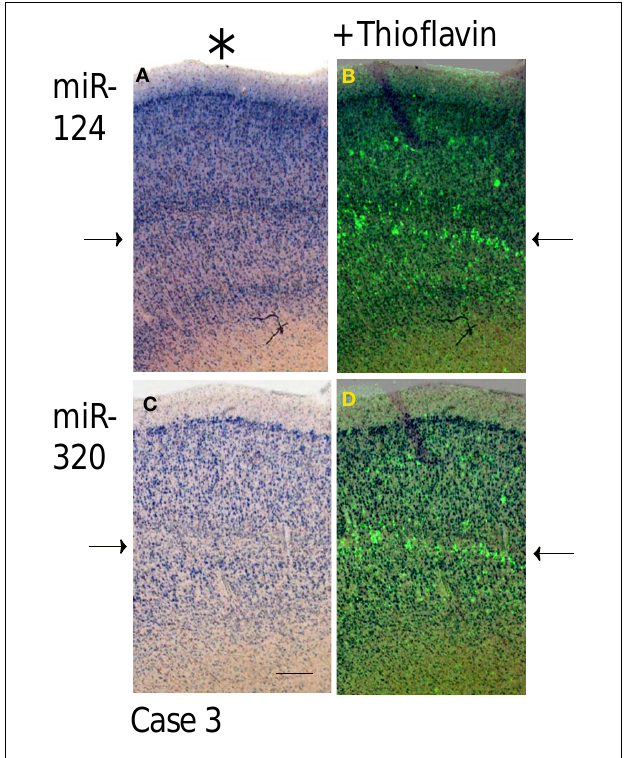
FIGURE 4 | Comparison in staining patterns using ISH with miRNA probes and Thiofl avine S on Case 3. Photomicrographs from sections stained with miR-124 (A) and miR-320 (C) were overlaid with near-serial sections stained with Thiofl avine S ( B and D ). Note that for both miR-124 and miR-320, it is layers with a relative paucity of ISH stain (arrows on the left) that are most intensely stained with the Thiofl avine S (arrows on the right). Pial surface is indicated in A with an asterisk. Scale bar = 300